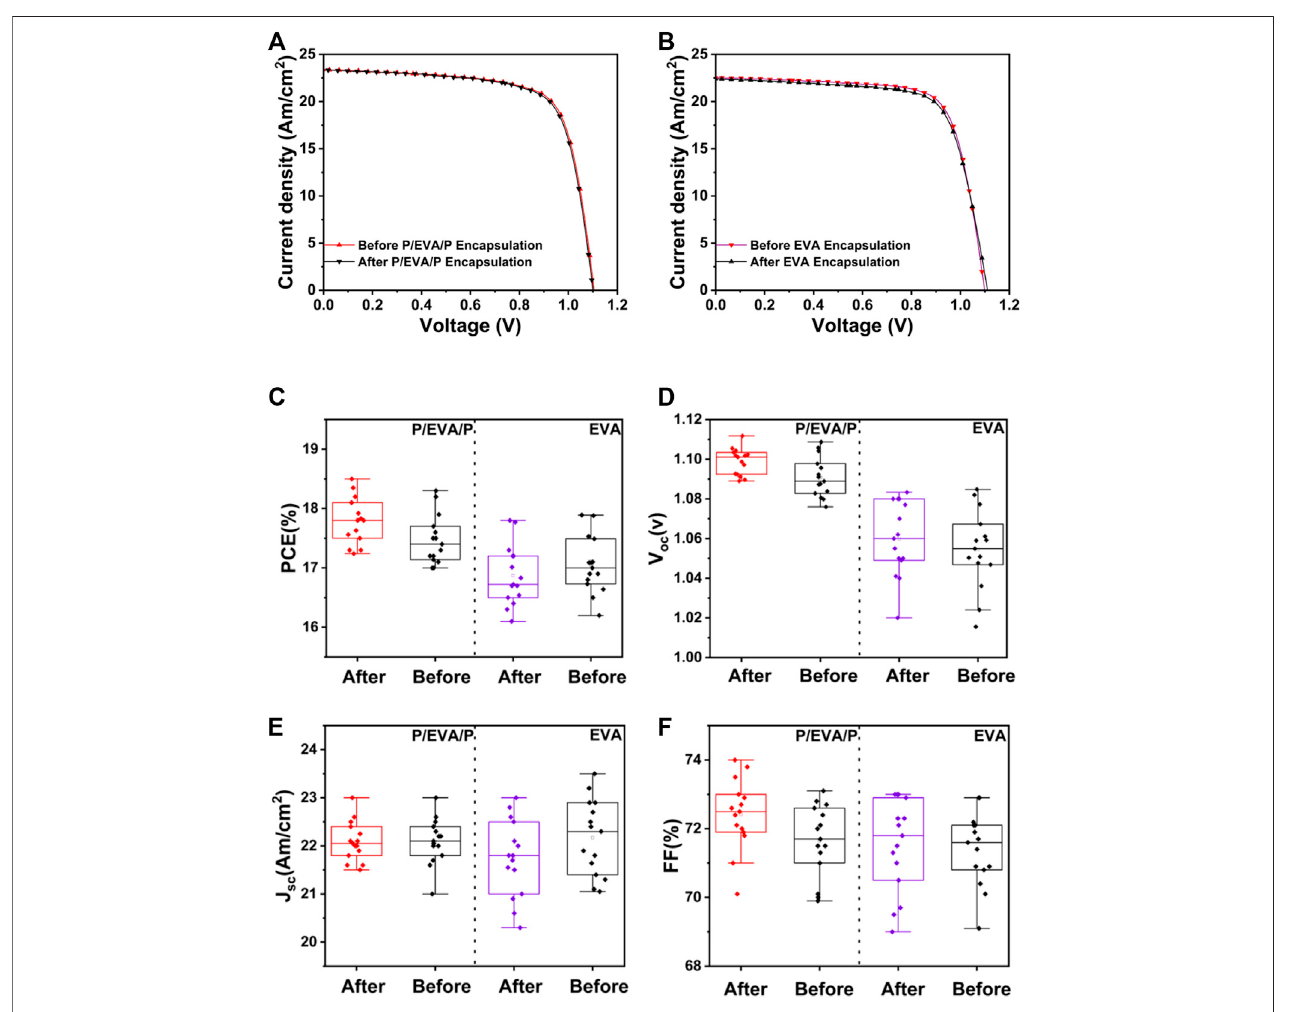
FIGURE2| J – VcurvesofPSCsbeforeandafterparaf fi n/EVA/paraf fi n/glass (A) andEVA/glass (B) encapsulation.Statisticaldeviationfrom15devicesofeachkind of PSCs for photovoltaic parameters of PCE (C) , V OC (D) , J SC (E), and FF (F) before and after encapsulation.